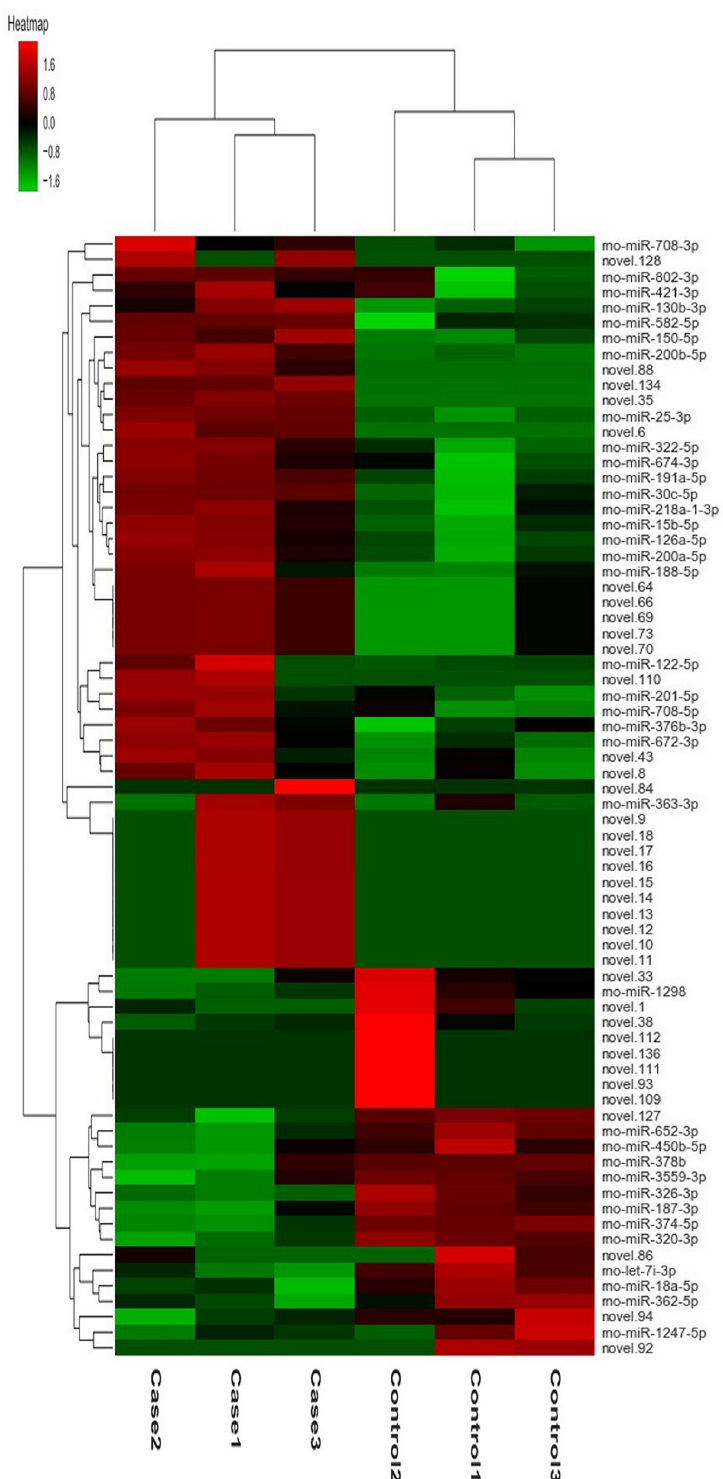
Fig 2. Hierarchical clustering analysis of the 72 DE miRNAs in the CI-AKI and control group. Each group includes 3 duplicates. The DE miRNAs includes 36 mature and 36 novel ones ( P < 0.05). Colors from green to red represent the miRNA expression abundance from poor to